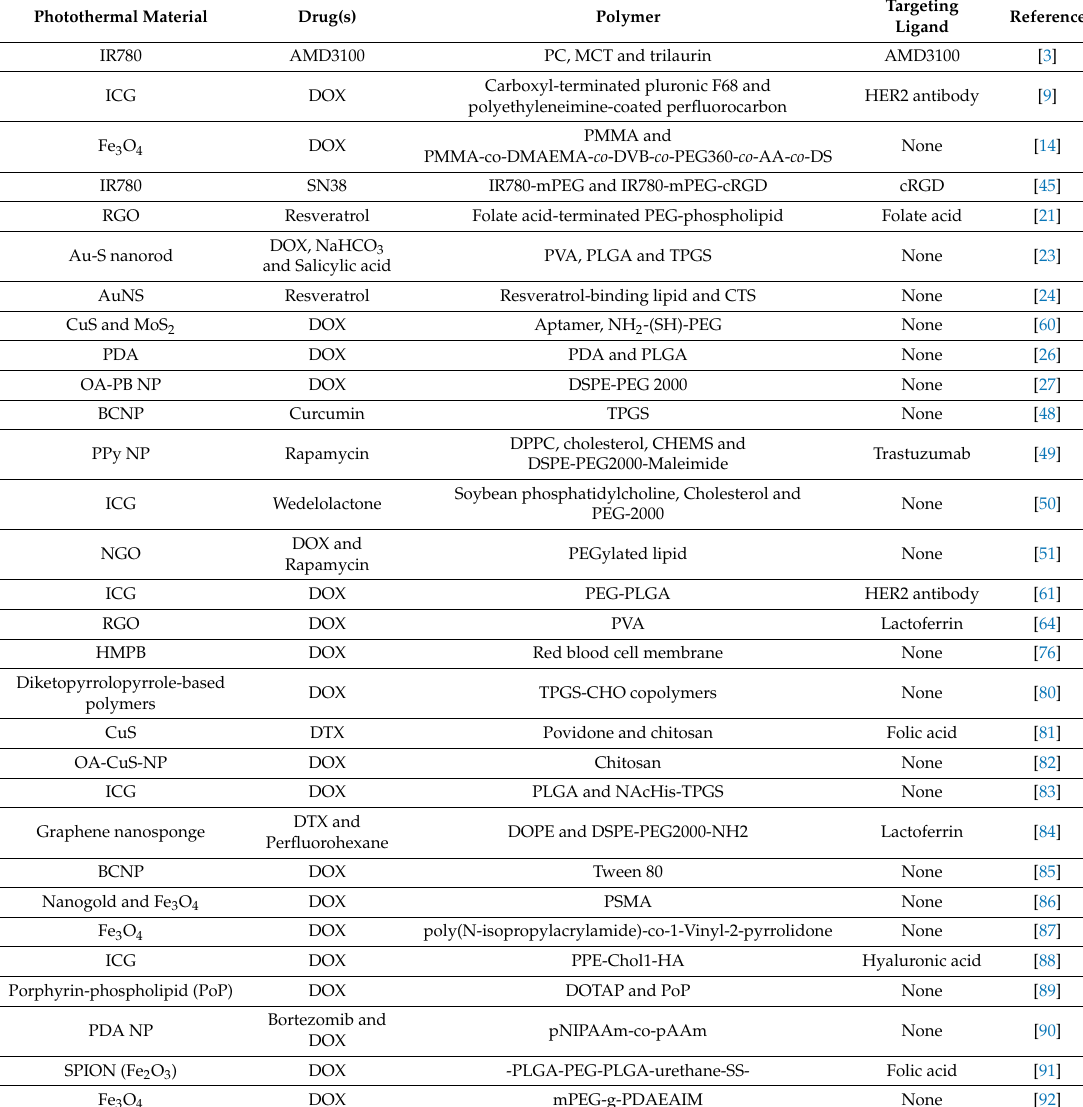
Table 1. List of Core-shell Structured